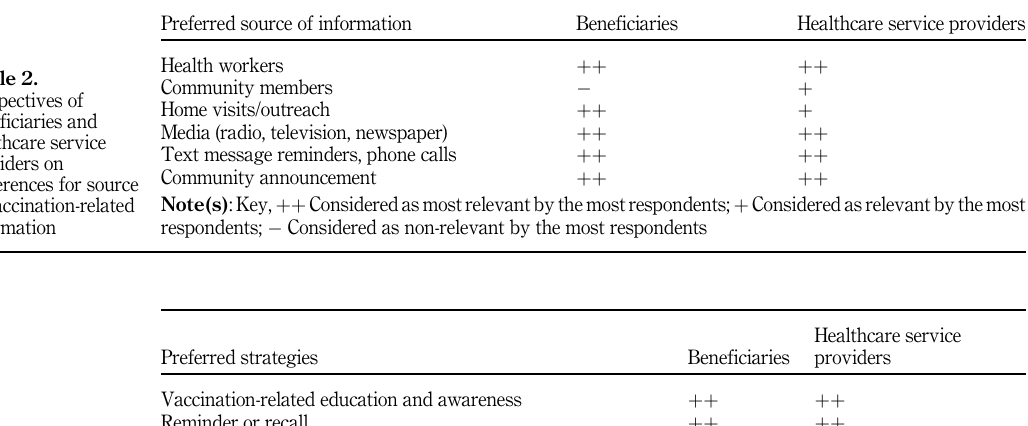
beneficiaries and healthcare service providers on preferred strategies to improve the vaccination